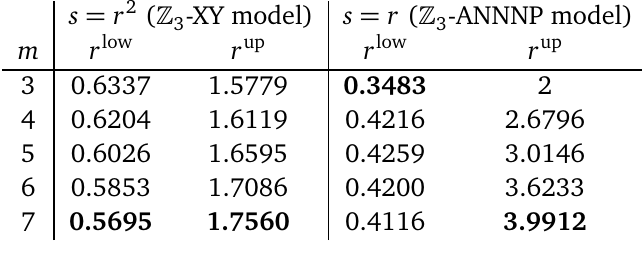
Table 1: Lower and upper limit r low,up for the gapped regions of the (cid:90) -XY model 3 (84) and (cid:90) -ANNNP model (91) as deduced from different sub-system sizes m . The 3 bold values indicate the extremal values which are stated in the main text. s = r 2 ( (cid:90) -XY model) s = r ( (cid:90) -ANNNP 3 3